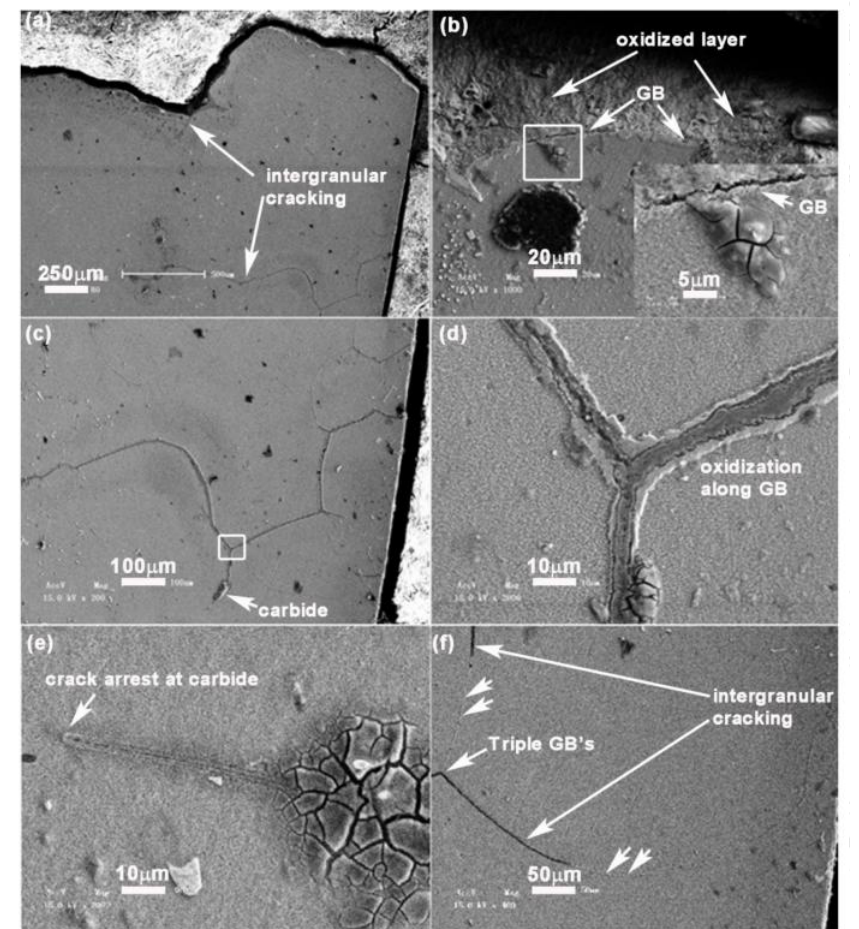
Figure 10. Fracture features on the longitudinal section of the single crystal superalloy with local recrystallization at 850 ◦ C ( N f = 5235 cycles): ( a ) overview; ( b ) grain boundary (‘GB’) on the fracture surface; ( c ) intergranular cracking; ( d ) oxidation of GB; ( e ) crack arrested by carbide; ( f ) cracking of GBs in